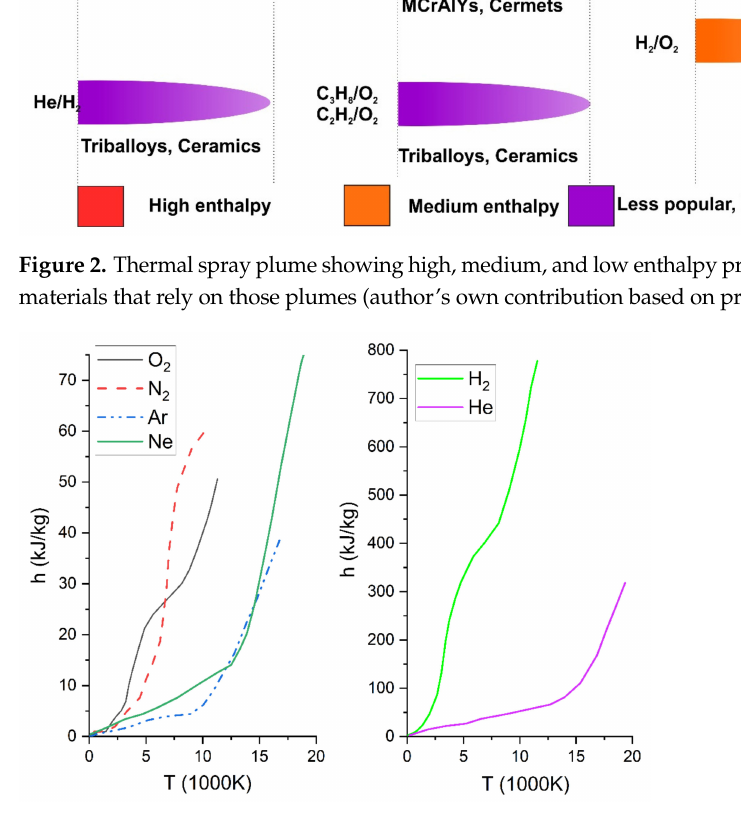
Figure 3. Enthalpy of diatomic gas vs. monoatomic gases—adapted from